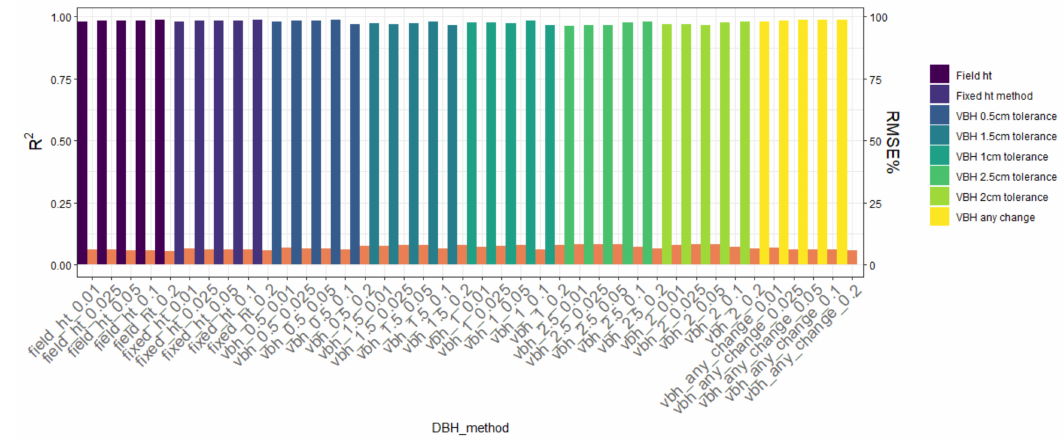
Figure 9. Correlation and relative RMSE values of each DBH methodology assessed. R 2 values represented by bars coloured by DBH method used, and relative RMSE represented by orange bars. The tolerance represents the minimum change in stem diameter between neighbouring stem slices, with tolerance of 0.001 referred to as “any change”.